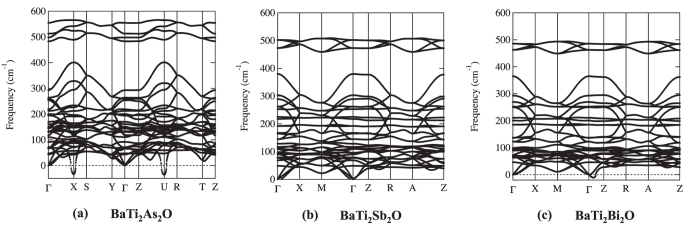
Phonon dispersions of superlattice structure for BaTi2Pn2O (Pn = (a) As-1 × 2 × 1, (b) Sb-, and (c) Bi-.